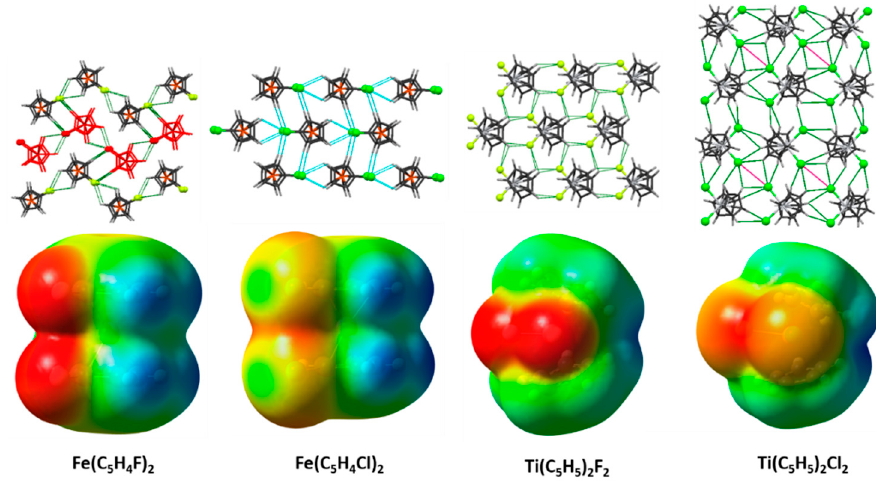
Figure 9. Primary supramolecular arrangements of Fe(C 5 H 4 X) 2 , and Ti(C 5 H 5 )X 2 (X = F, Cl) ( top ); electrostatic potential mapped onto an electron density isosurface for the same compounds ( bottom ).